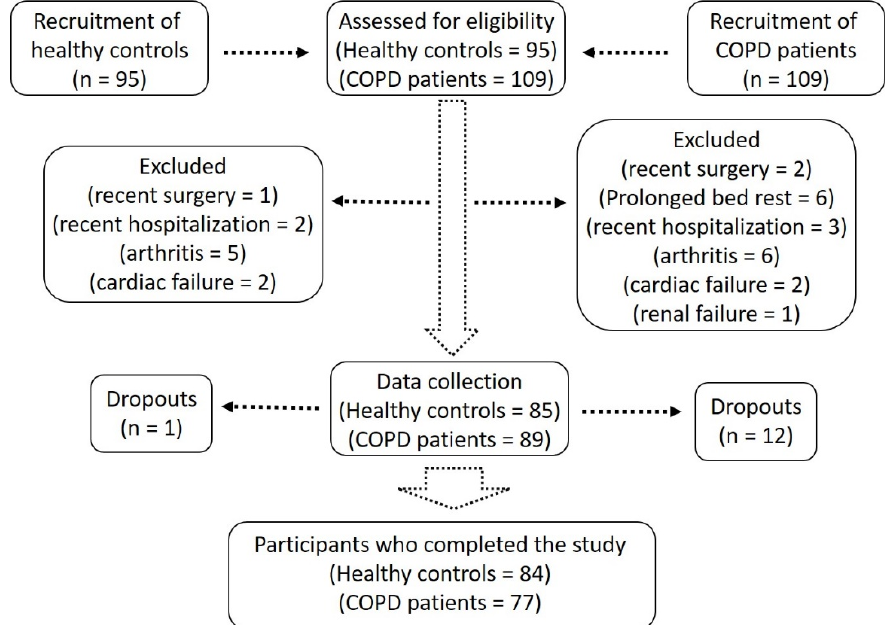
Figure 1. Flow diagram of the study participants.